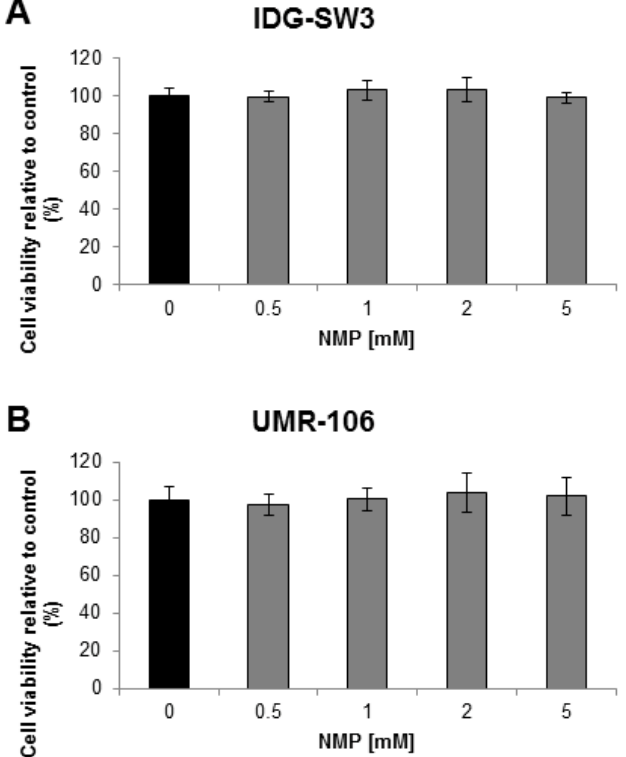
Figure 1. Cell viability dependent on the N -methyl pyrrolidone (NMP) concentration. ( A ) Differentiating IDG-SW3 cells were treated with NMP in a range from 0.5–5 mM over a time period of 9 days. ( B ) UMR-106 cells were treated with NMP in a range from 0.5–5 mM over 48 h. WST-1 cell viability assessment at collection time revealed no toxicity at NMP concentrations up to 5 mM.